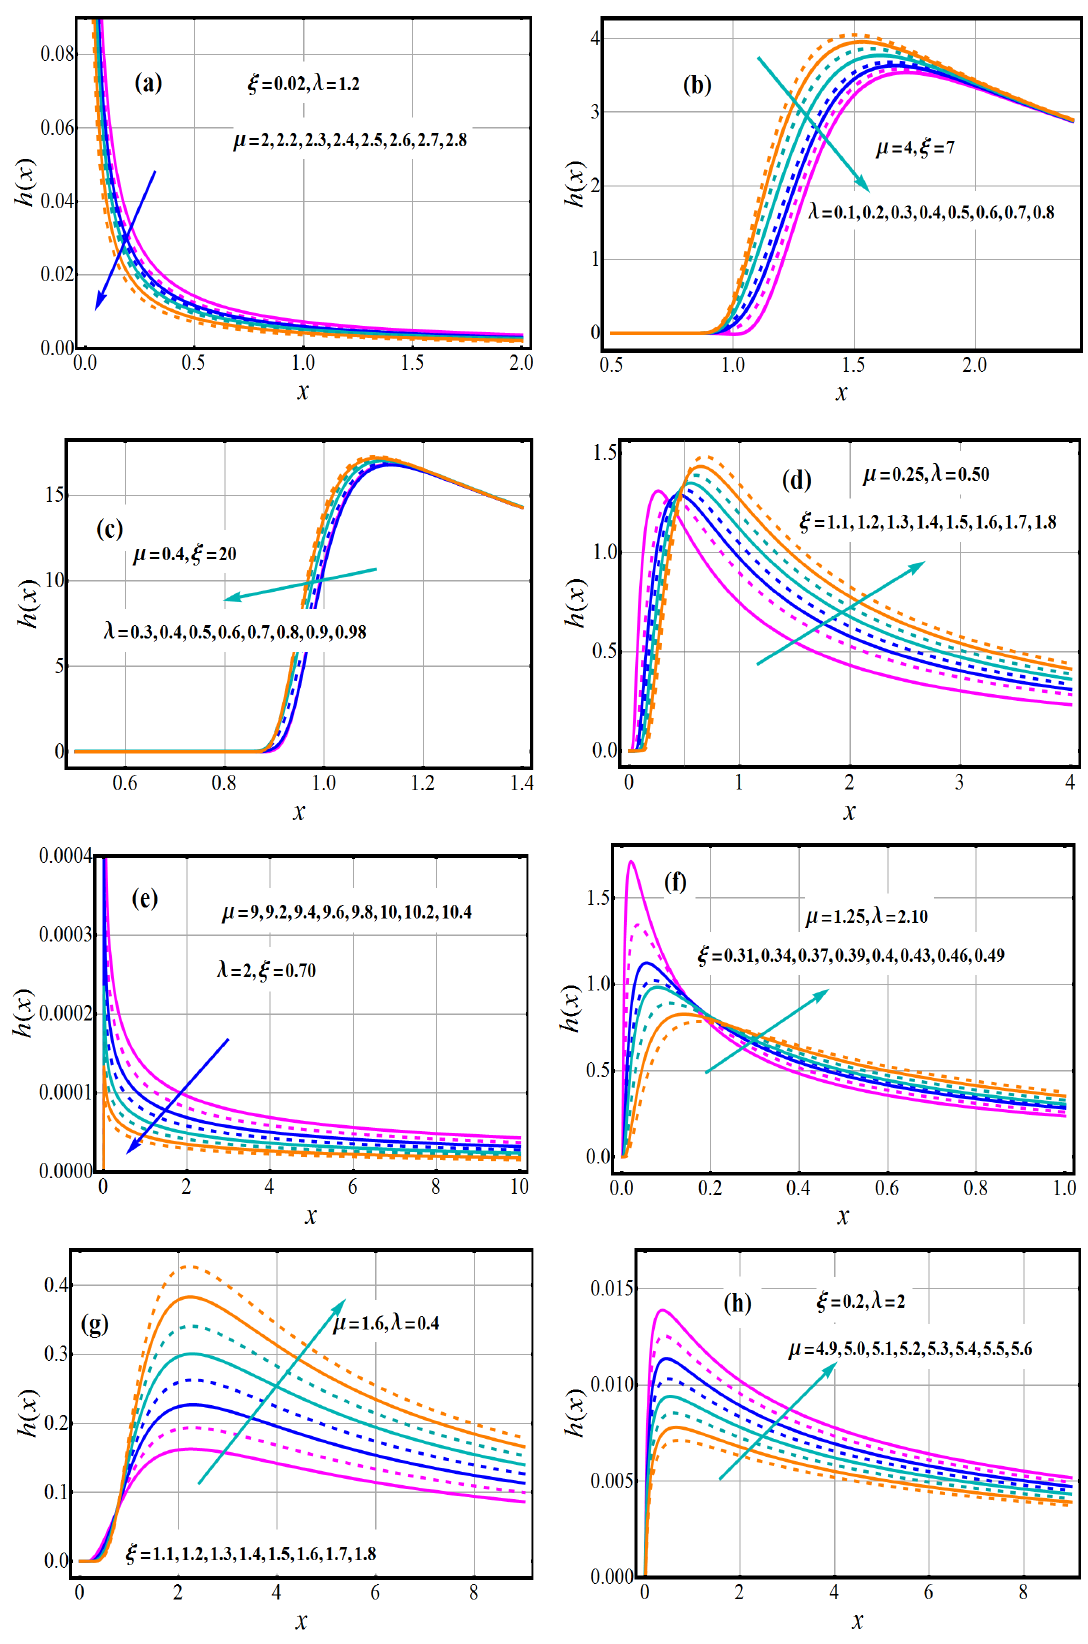
Fig. 2. The performance of FRF pro(cid:133)le of NIGT-II model against the (cid:22); (cid:24) and (cid:21) . Figure 2. The performance of the FRF profile of NIGT-II model against the µ , ξ and λ ( a – h